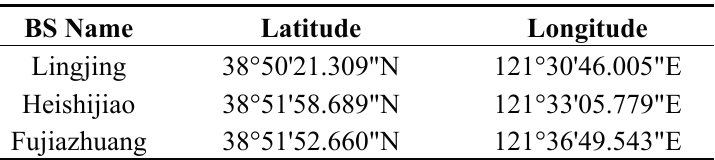
Table 1. Location information of base stations.